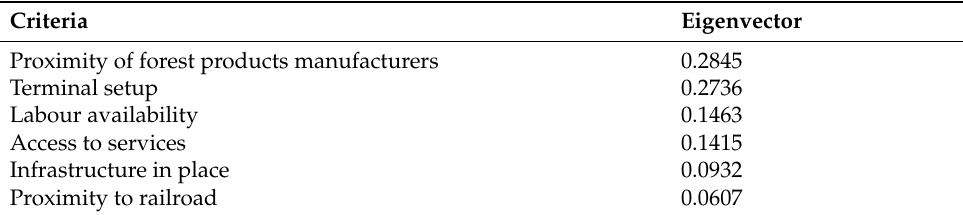
Table 4. The relative ranking of terminal selection criteria.